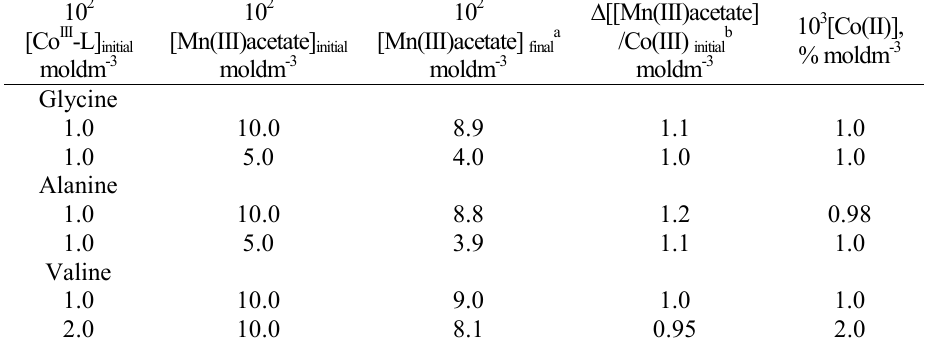
Table 1. Stochiometric data in the Mn(III)acetate oxidation of Co(III) bound Glycine, Alanine, and